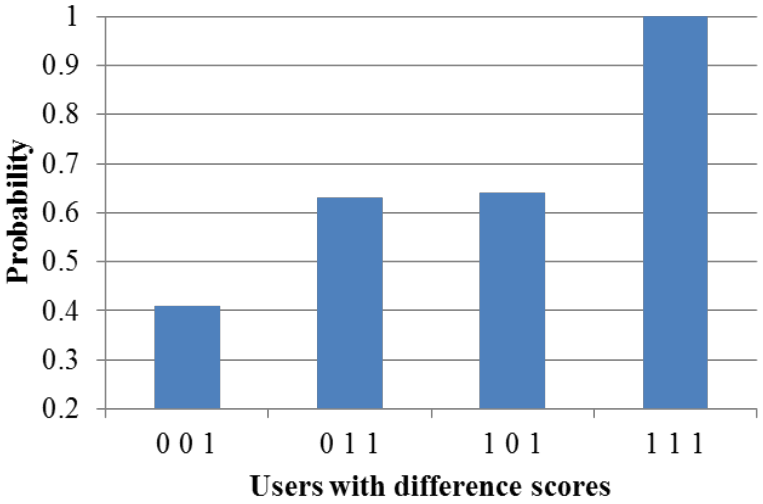
Figure 12. Finding results when α = 0.1, β = 0.1, and γ = 0.8.